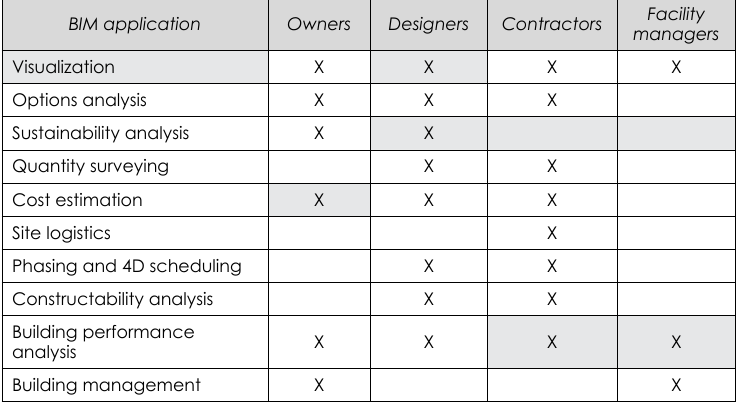
BIM applications for project stakeholders in the building construction